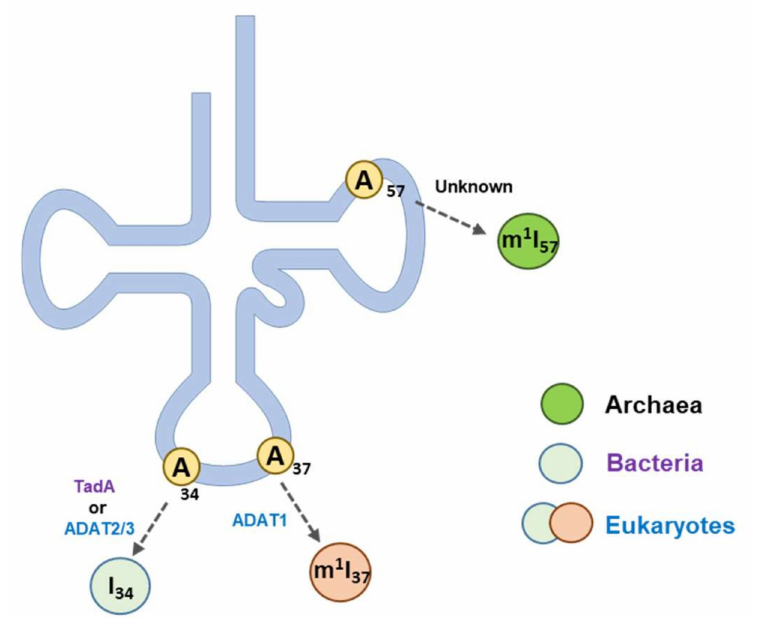
Figure 5. A-to-I editing in tRNAs. Adenosines at positions 34, 37, and 57 of tRNAs can be modified to inosines. The A 34 -to-I 34 modification is observed in bacteria and eukaryotes and is catalyzed by the enzymes TadA and ADAT2/3, respectively. ADAT1 catalyzes A 37 -to-I 37 modification in eukaryotic tRNA Ala . I 57 modification was observed in archaeal tRNA Ile . Adenosines at positions 37 and 57 are modified to methylated forms of